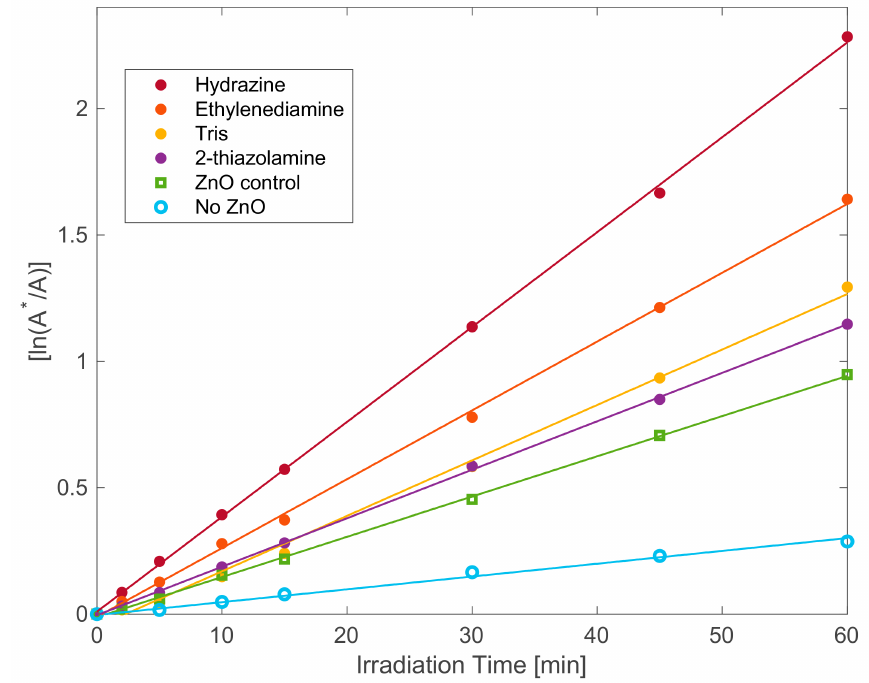
Figure 8. Absorption data of malachite green solutions during photodegradation by ZnO prepared by rapid precipitation. The amines used to make the [Zn(acetate) 2 (amine) x ] precursors are identified by the labels in the legend. R 2 values for all of the best fit lines exceed 0.997. Table 2. Photodegradation of malachite green using zinc oxide made from different precursors. Dye Conc. Catalyst Precursor (g/L)